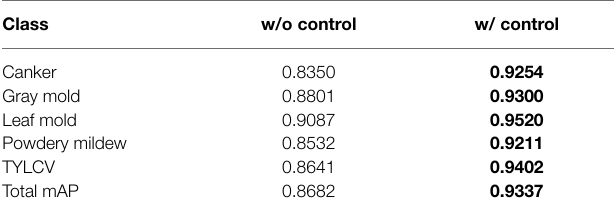
Bold values represent the best results for each